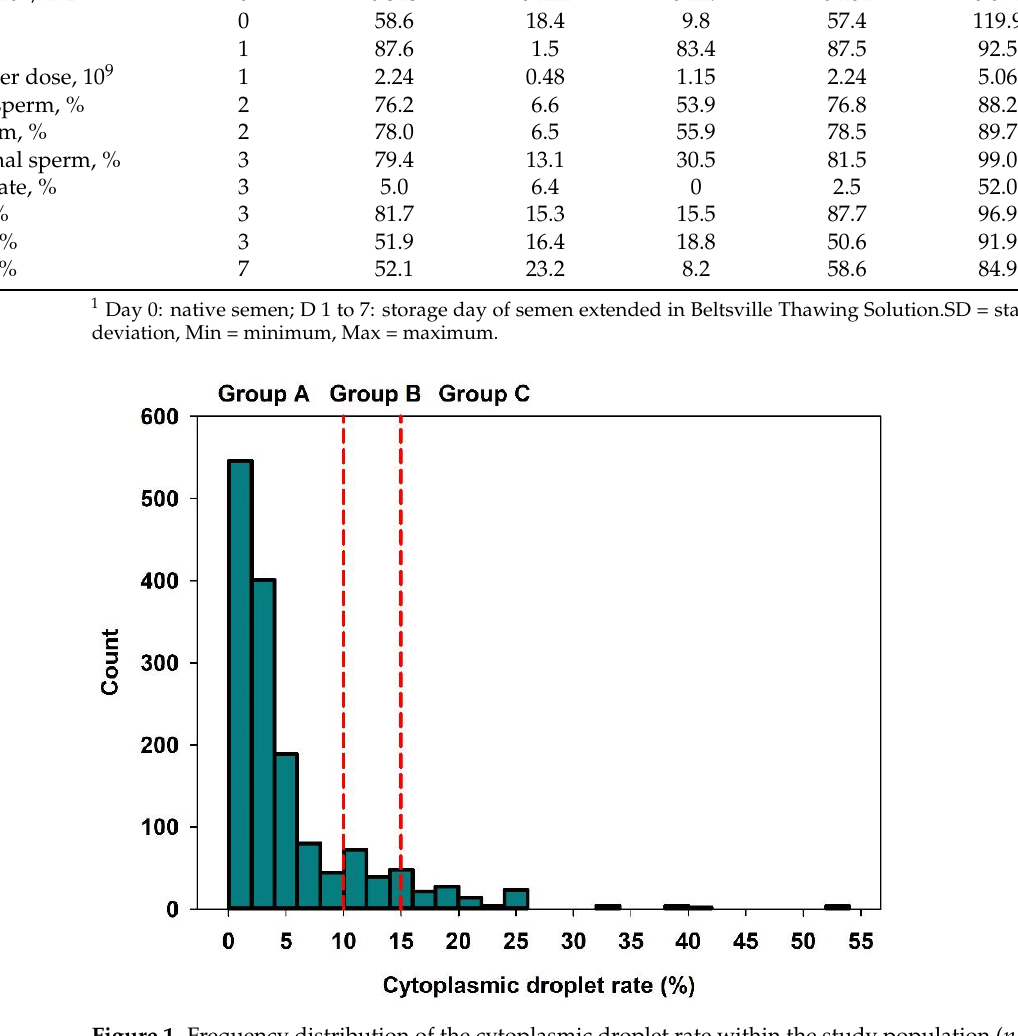
Table 2. Descriptive statistics of sow-related factors ( n = 1497 inseminations records) .